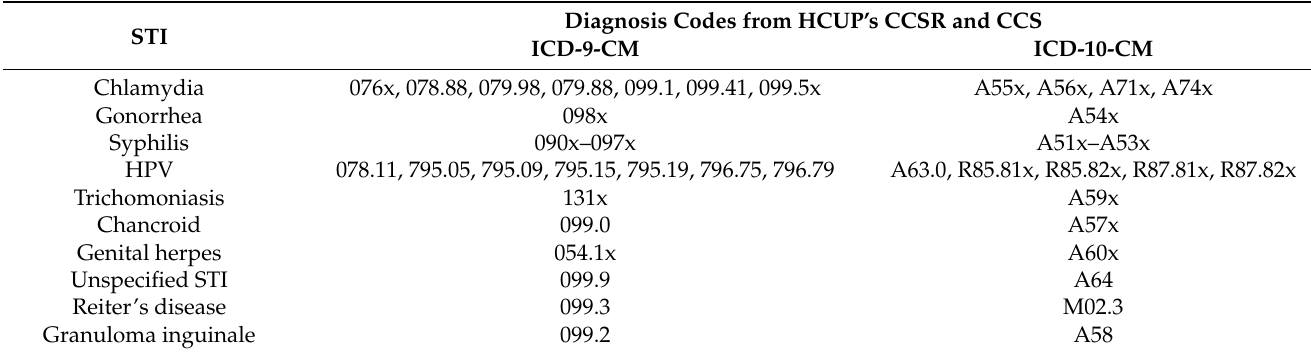
Table 1. Table of diagnosis codes for STIs included in the